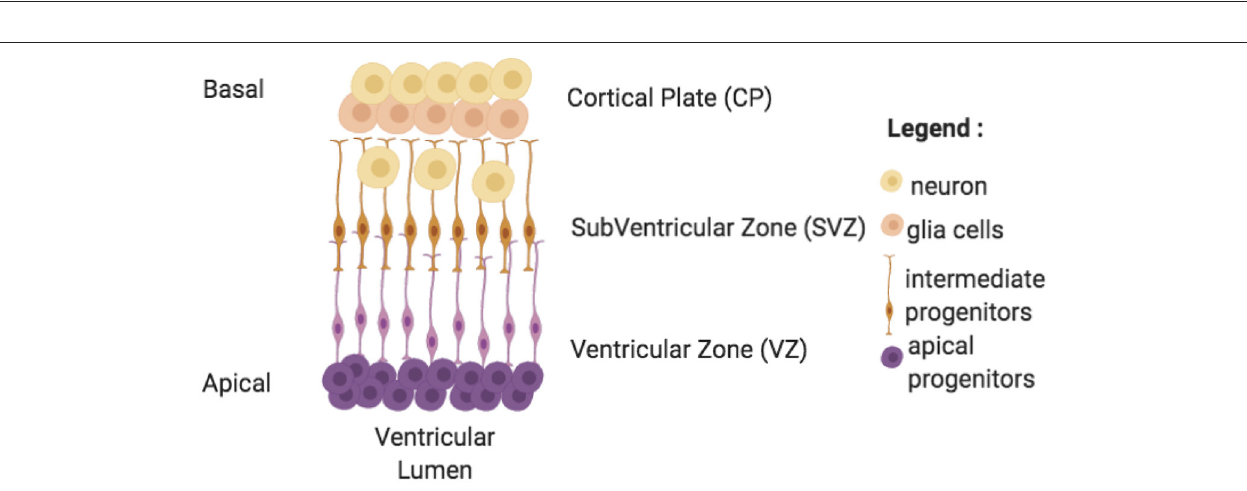
FIGURE 3 | Evolution of 3D brain cultures over time. Non-brain cultures which led the way are labeled in italics. The abbreviation CO is used for “cerebral organoid”.